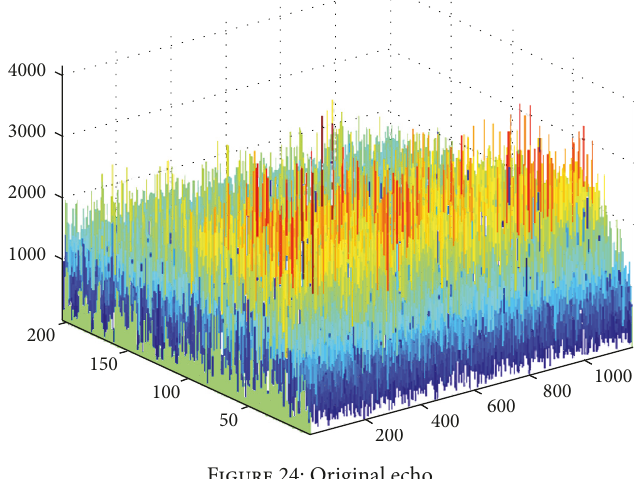
Figure 24: Original echo.